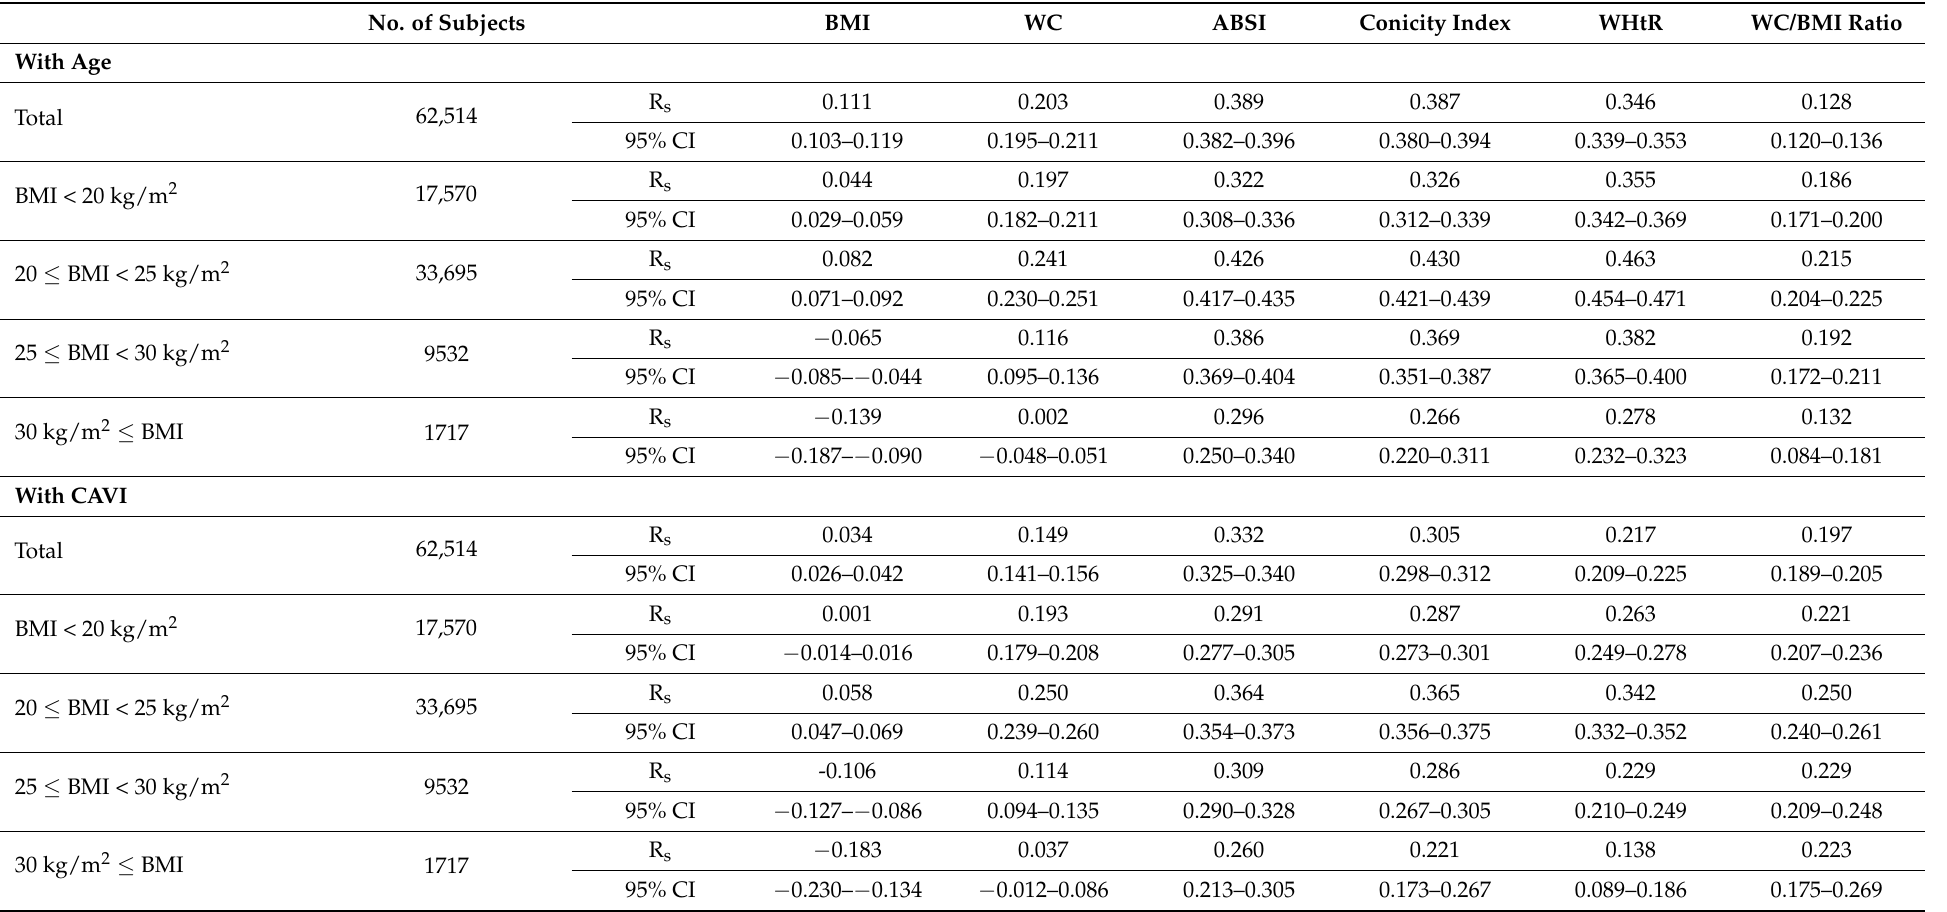
Table 2. Correlation of age or CAVI with each adiposity index by obesity